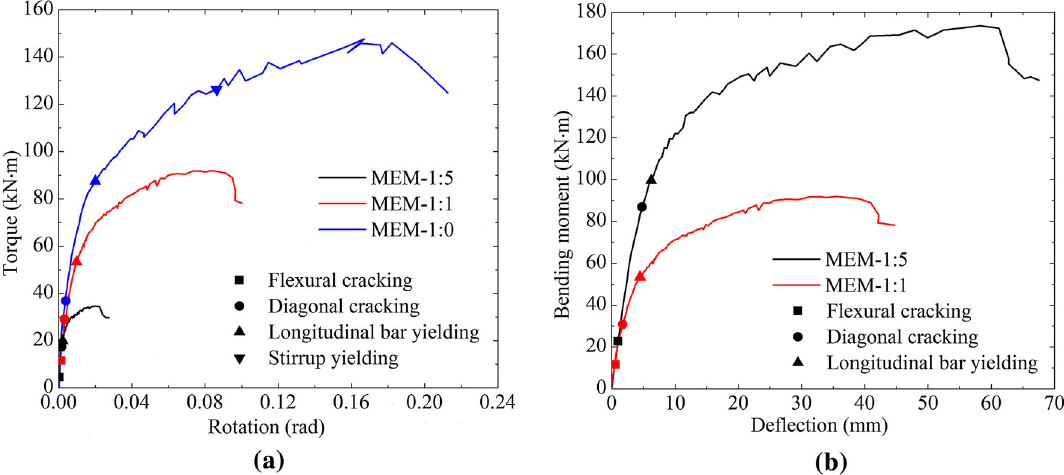
Fig. 7 Torque–rotation and bending moment–deflection curves of beam specimens at mid-span: a rotations and b